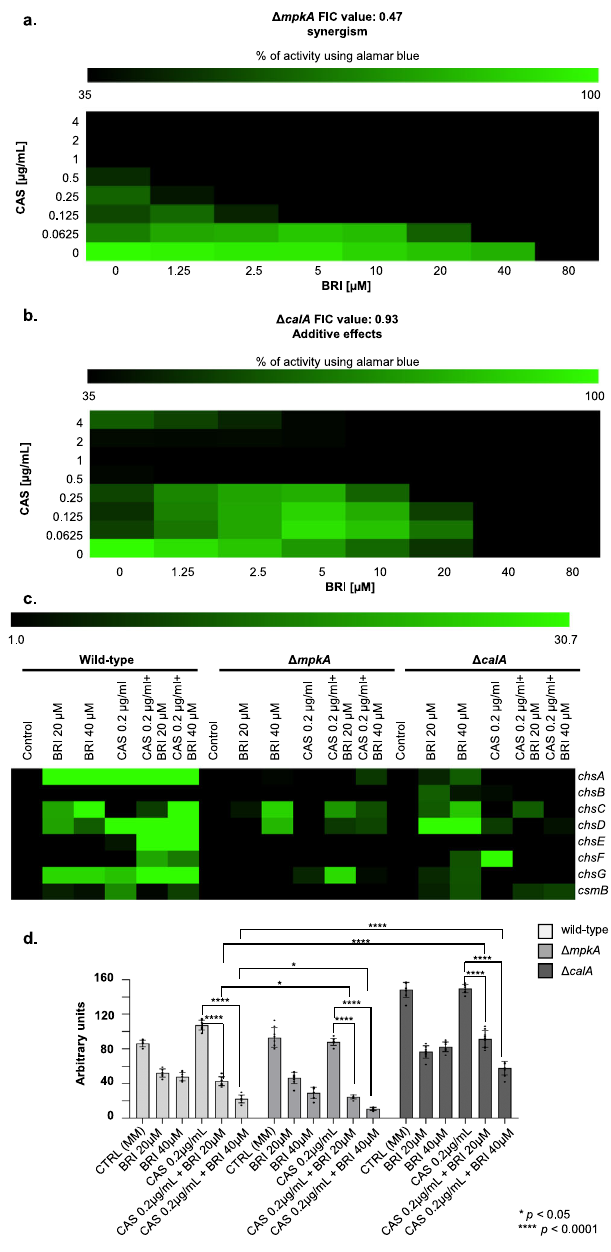
Fig. 4 | BRI acts in A. fumigatus by affecting the cell wall integrity pathway. a , b TheFractionalInhibitoryConcentration(FIC)indexforBRI+CASinthe Δ mpkA and Δ calA mutant strains. The results are the average of three independent experiments. c Chitin synthase mRNA accumulation in A. fumigatus wild-type, Δ mpkA and Δ calA strains. A. fumigatus strains were grown for 24h at 37°C and exposed or not to CAS [0.2 µ g/mL CAS] combined or not with different con- centration of BRI for 1h. The results are the average of three independent experi- ments analyzed in technicalduplicateseach. d Exposureof chitinand asmeasured by Calco fl uor White (CFW). The results graphic shows the value of nine technical replicatesfromthreeindependentexperiments±SDdeviation( n =3;2wayANOVA, Dunnet´s post-test; * p <0.05 and **** p